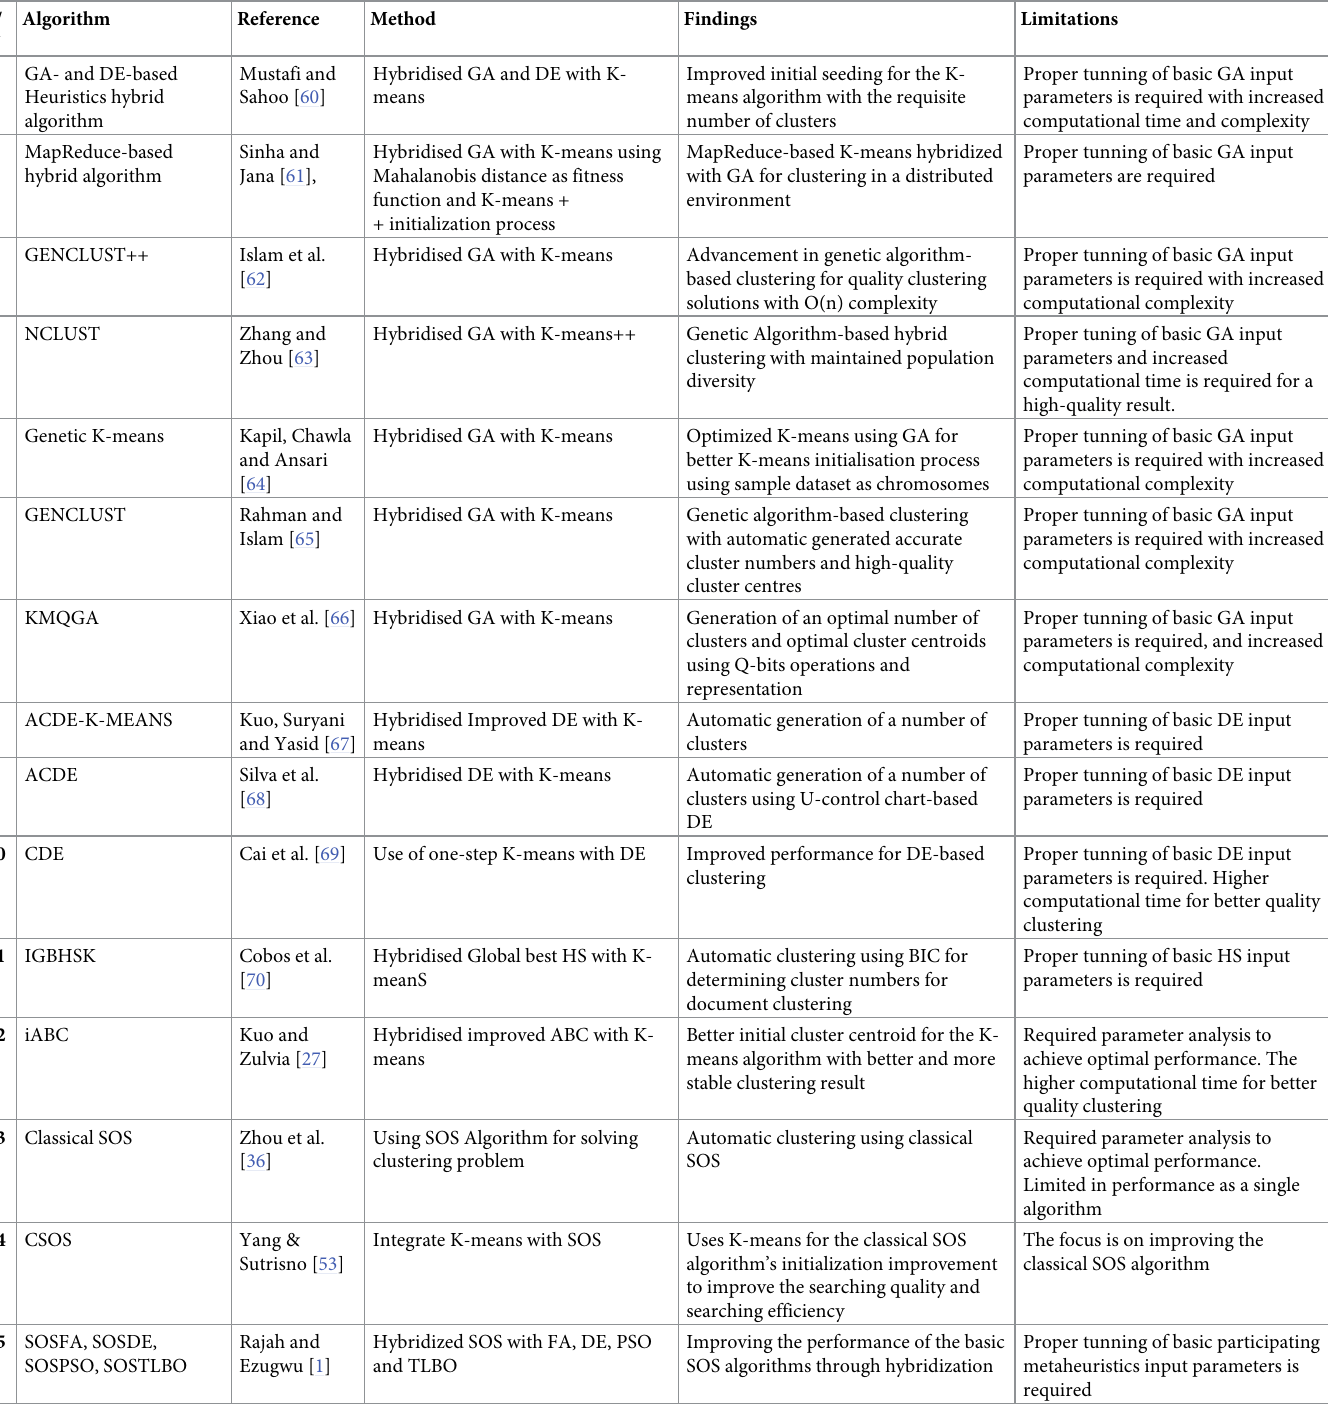
Table 1. Summary of literature review on K-means hybridization with metaheuristic